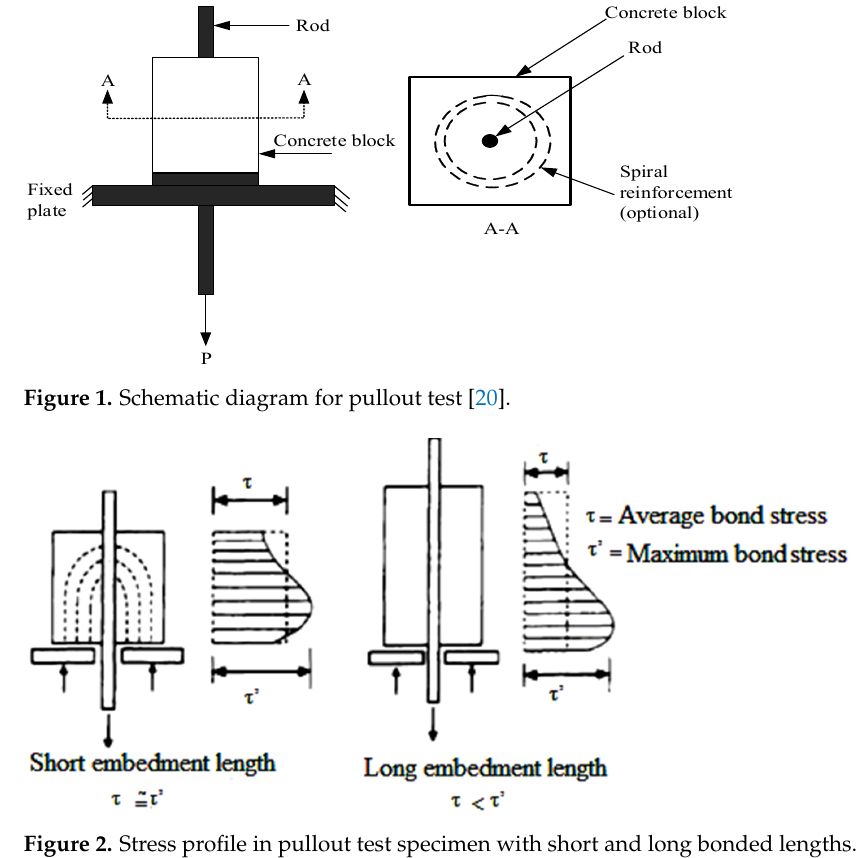
Figure 2. Stress profile in pullout test specimen with short and long bonded lengths.